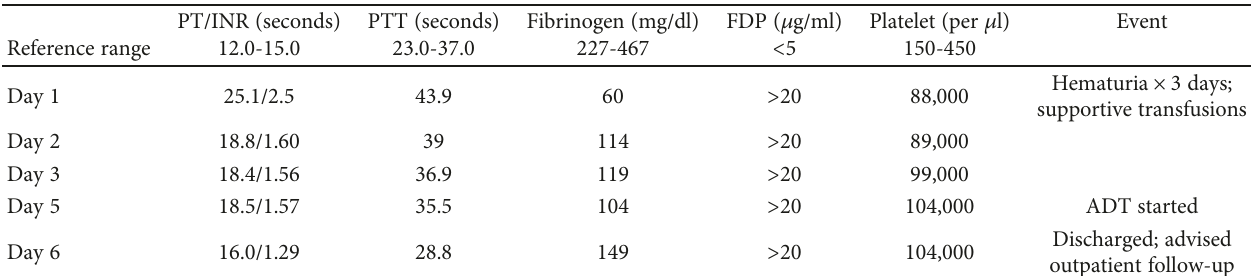
(a) Trend of laboratory abnormalities on 1 st